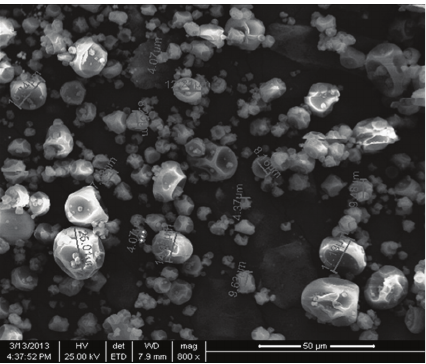
Figure 1: Scanning electron microscopy photograph of encapsu- lated powder containing antioxidant-rich algal extract obtained by SC-CO 2 at a magnification of